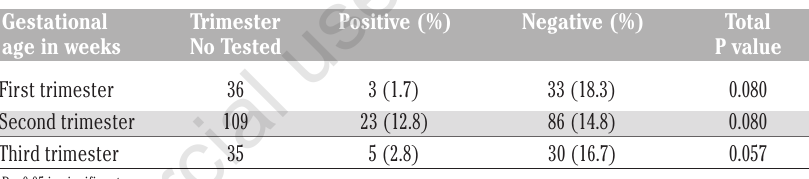
Table 5. Distribution based on trimesters.